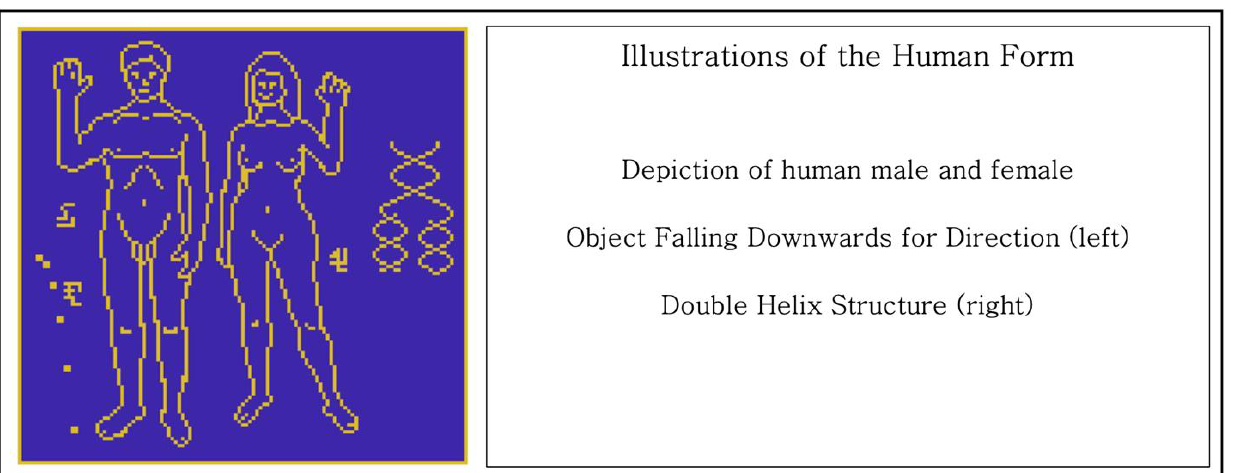
Figure 14. Pictural representation of humans and double helix in the message, Page 8.